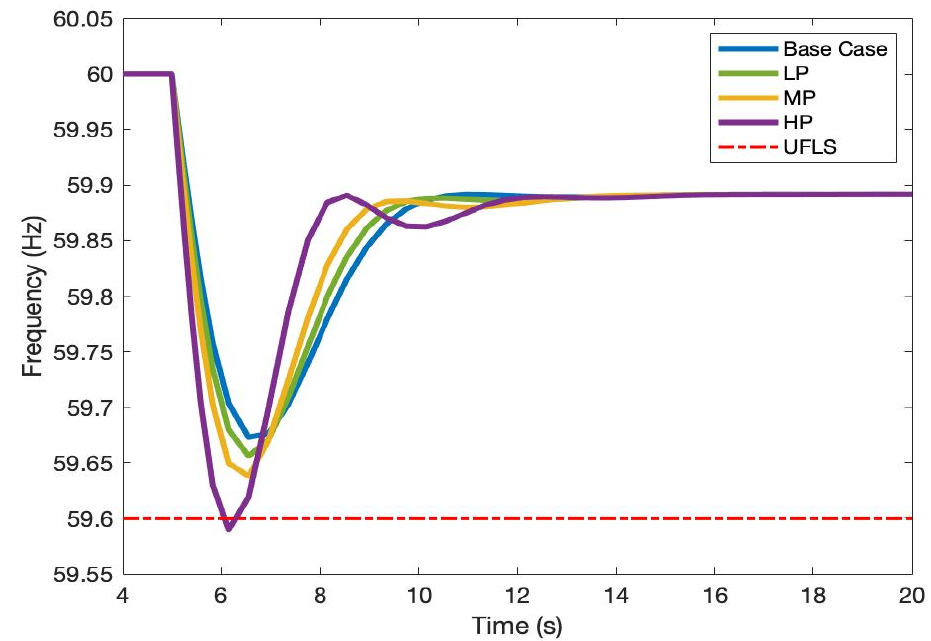
Figure 10. Frequency response under peak load conditions in 2030. Table 8. Online generation capacity under base load conditions in